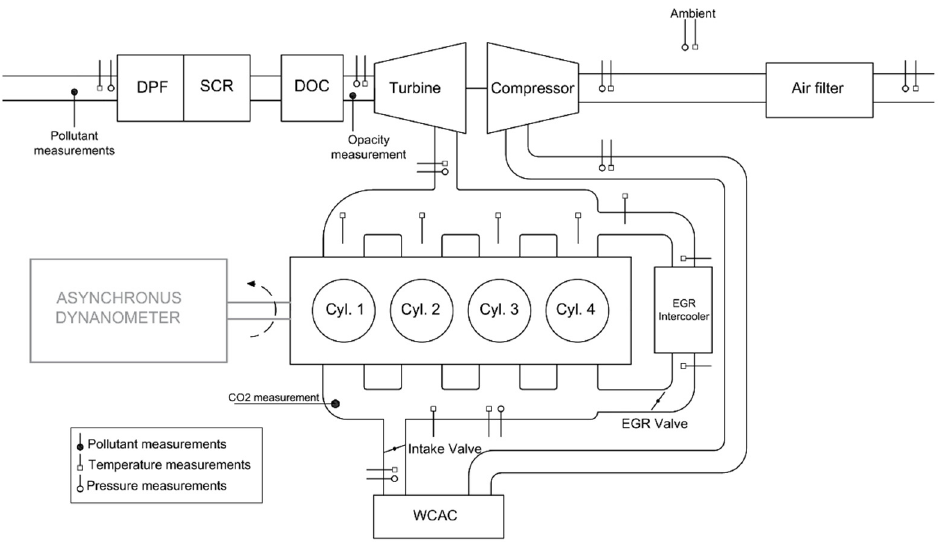
Figure 1. Engine layout.